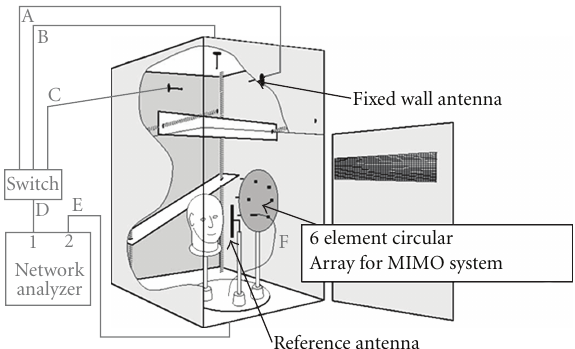
Figure 1: Drawing of the Bluetest RC with two mechanical plate stirrers, platform, three wall antennas, and six-monopole